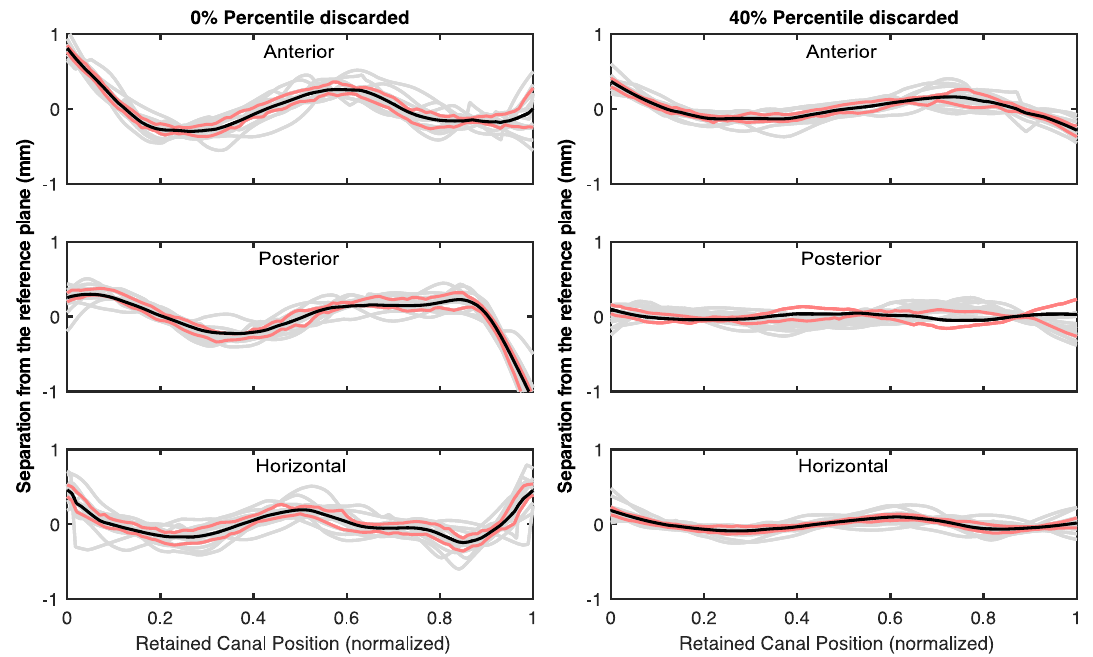
Figure 9. A, P and H non-planarity (defined as normal distance) referred to the reference plane: ( left ) this distance when the whole duct is retained; and ( right ) the evolution of this distance when the 40th percentile is discarded. Grey lines represent different volunteers, the black line is the average and the red lines represent the limits for one standard deviation for each SCs.